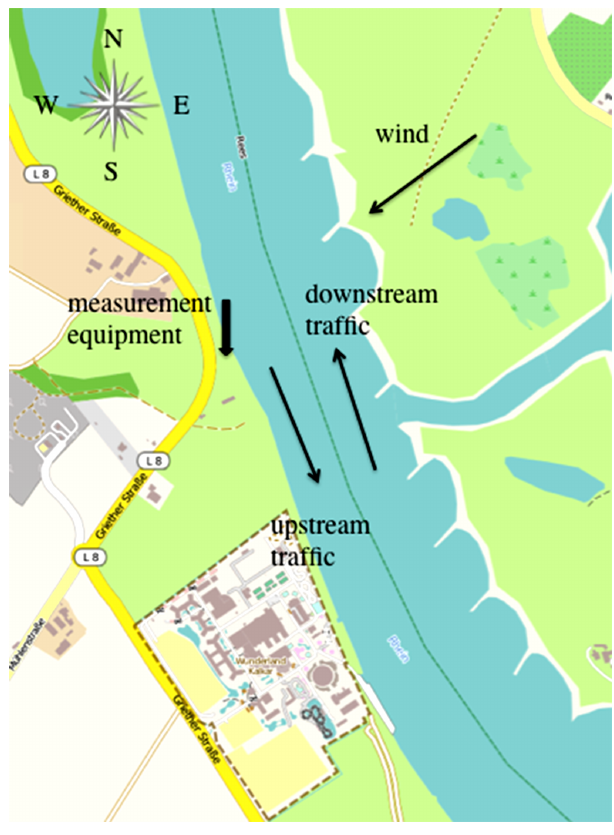
Figure 1. Location of the measurement site at Rhine kilometre 843. (This map is made available under the Open Database Li- cense: http://opendatacommons.org/licenses/odbl/1.0/. Any rights in individual contents of the database are licensed under the Database Contents License: http://opendatacommons.org/licenses/ dbcl/1.0/; see more at: http://opendatacommons.org/licenses/odbl/